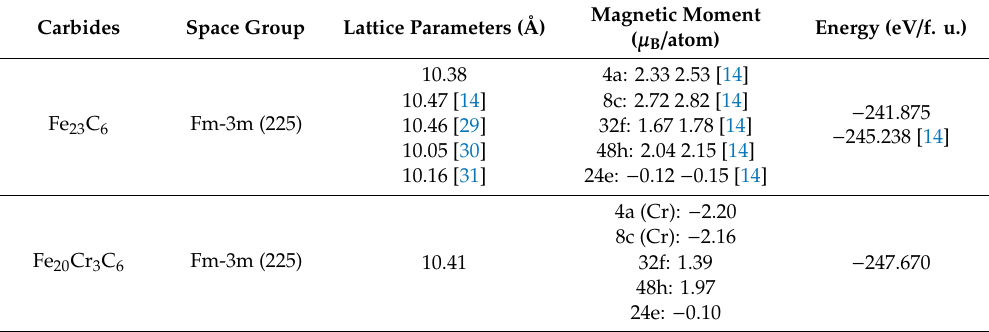
Table 2. Calculated lattice parameters, local magnetic moment and energy per formula for Fe 23 C 6 and Fe 20 Cr 3 C 6 . The lattice parameter is compared with theoretical values calculated by Vienna Ab-initial